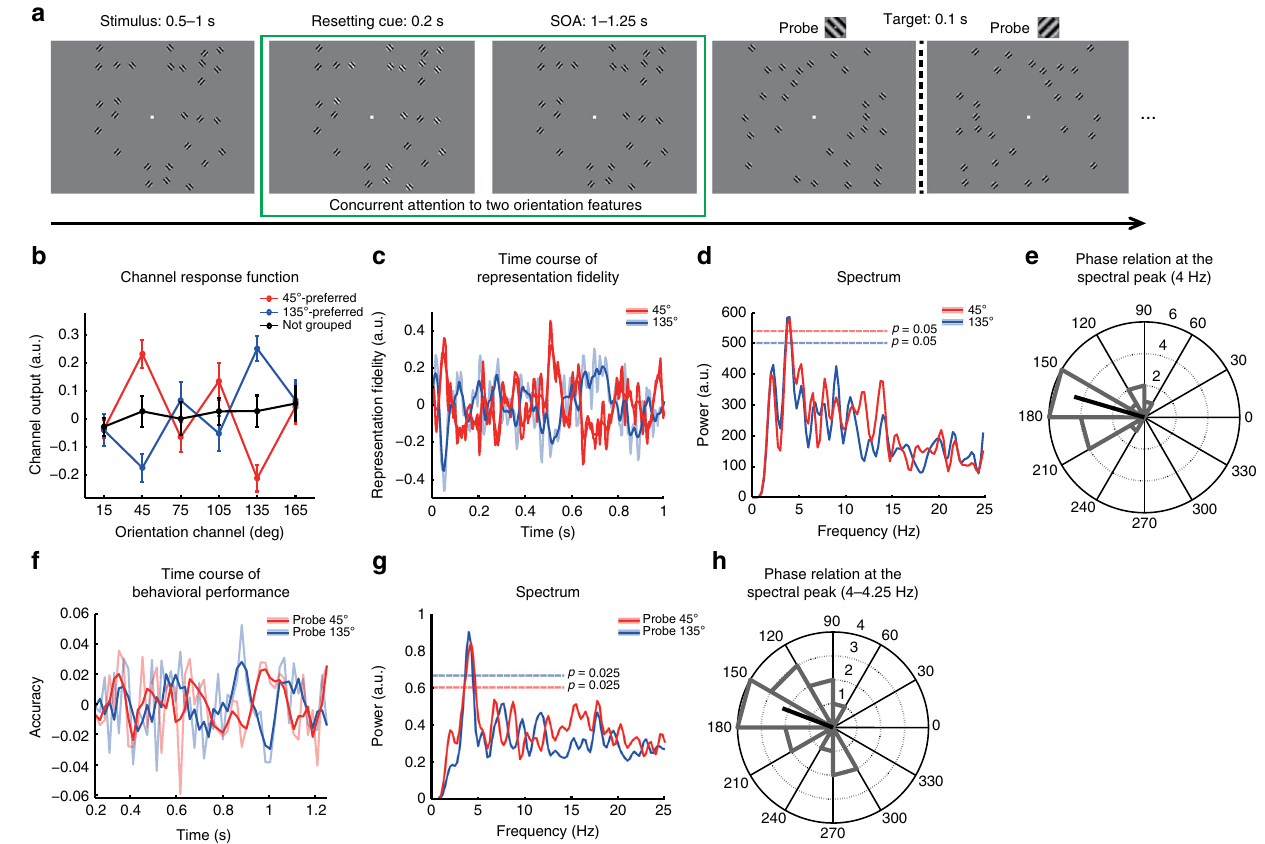
Fig. 2 Rhythmic fl uctuation of the orientation representations. a Trial structure in the attention part. b – e MEG results in the attention part. b Mean channel response functions with the preferred channel being the 45° channel (red) and 135° channel (blue), respectively. Error bars denote one SEM across subjects. c Representation fi delity of the two attended orientations as a function of time relative to the resetting cue (zero point). For better visualization, the smoothed time courses (in saturated colors) are overlaid on the unsmoothed time courses (in desaturated colors). d Spectra of the representation fi delity time courses for the two attended orientations. Dashed lines denote the statistical thresholds (corrected for multiple comparisons). e Distribution of the phase difference between the two orientation representation fi delity time courses at the spectral peak (4 Hz) across subjects. The thick black bar indicates the mean of the phase differences. f – h Time-resolved psychophysical results. f Orientation discrimination performance as a function of time. g Spectra of the behavioral performance time courses for the two attended orientations. h Distribution of the phase difference between the two behavioral time courses at the spectral peaks (4 – 4.25 Hz) across subjects. The thick black bar indicates the mean of the phase